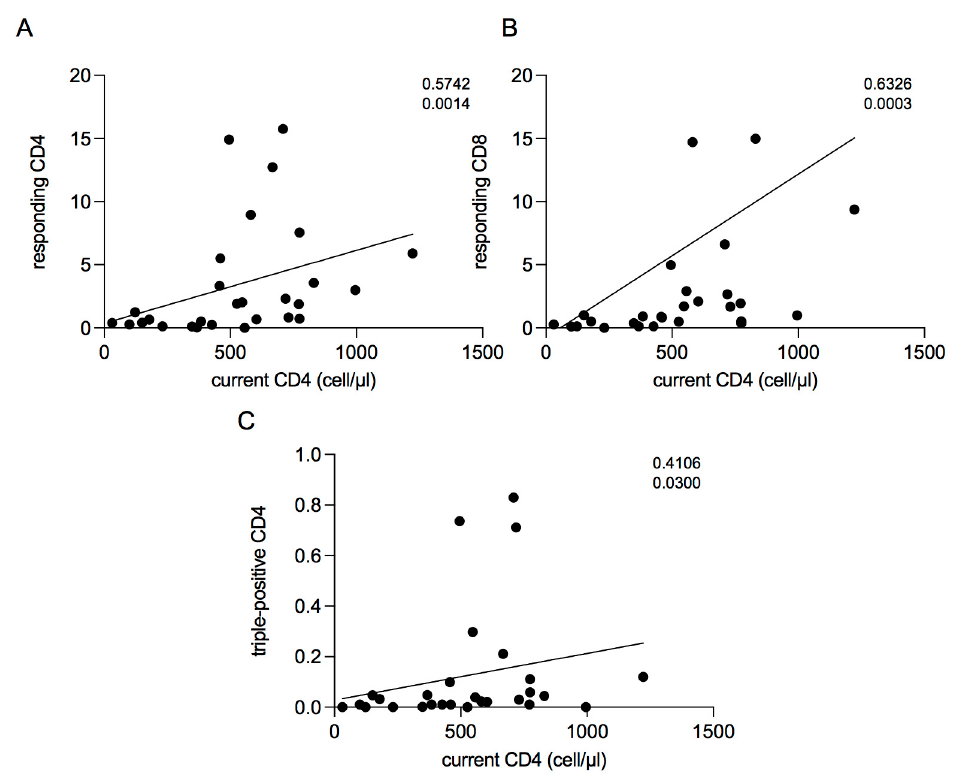
Figure 4. Correlations. ( A ) Positive correlation between CD4 current cell count and responding CD4 T cells ( ρ = 0.5742 p = 0.0014). Linear correlation was evaluated by using the regression test. ( B ) Positive correlation between CD4 current cell count and responding CD8 T cells ( ρ = 0.6326 p = 0.0003). Linear correlation was evaluated by using the regression test. ( C ) Positive correlation between CD4 current cell count and triple-positive CD4 T cells ( ρ = 0.4106 p = 0.0300). Linear correlation was evaluated by using the regression test. Linear correlation was evaluated by using the regression test. All correlations were performed using Spearman’s test.